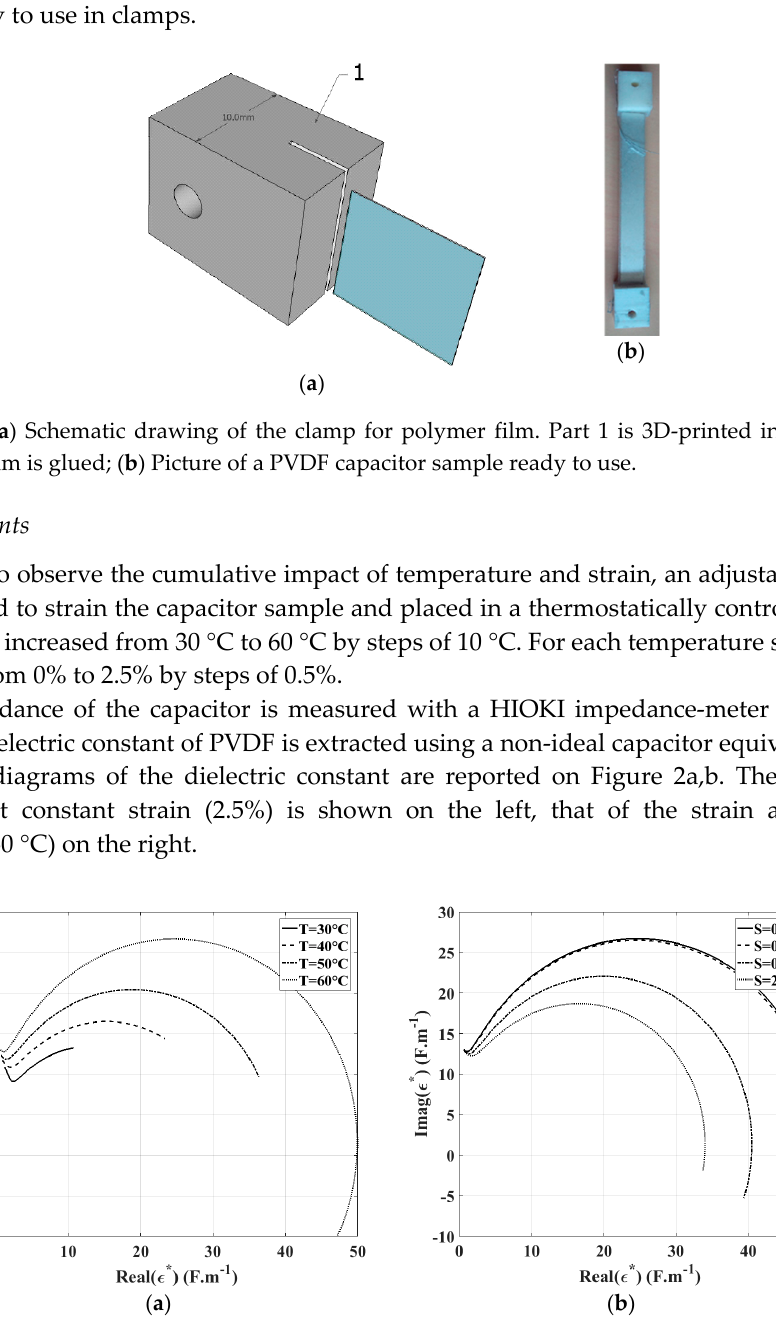
Figure 2. Nyquist diagrams of the PVDF dielectric constant, ( a ) with temperature change at constant strain (2.5%) and ( b ) with different applied strain at constant temperature (60